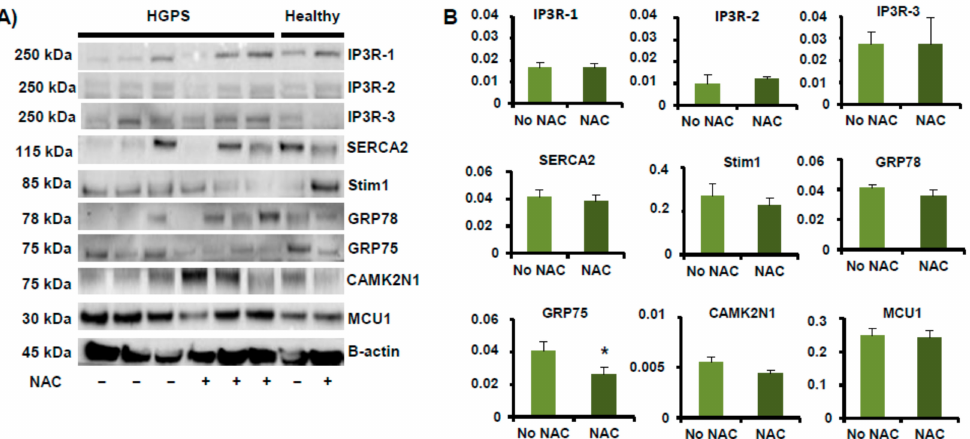
Figure 5. Effect of NAC on receptors involved in Ca 2+ signaling. ( A ) Western blots of lysates from HGPS (AG03198, AG03199, AG03513, and AG06917) human skin fibroblasts incubated with 10 µ M NAC and without treatment. The antibodies used are indicated in Table A2. ( B ) Densitometry results for normalized proteins relative to β -actin. Bars are means ± SEM from three independent experiments. * p < 0.05 was considered statistically significant.